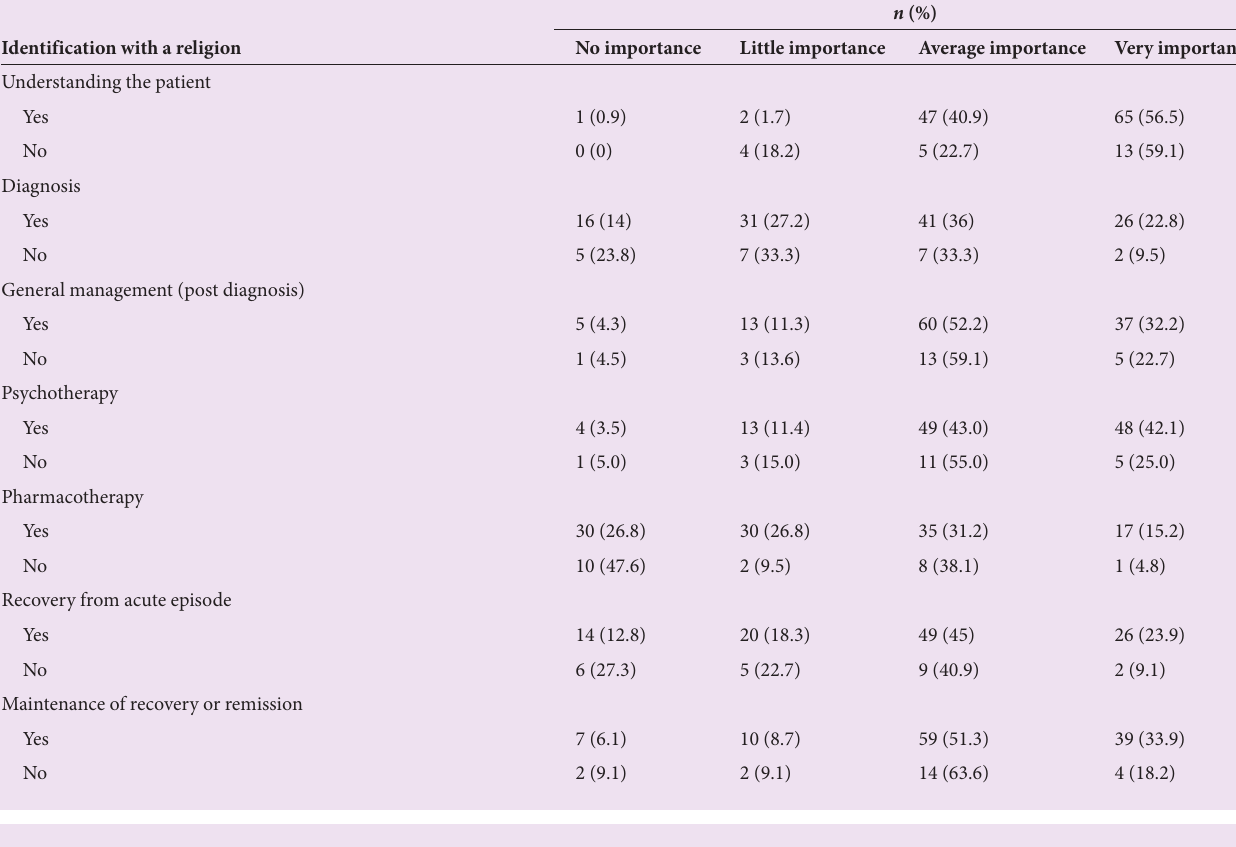
Table 1. Religious self-identification v. importance ascribed to patients’ religious beliefs Identification with a religion